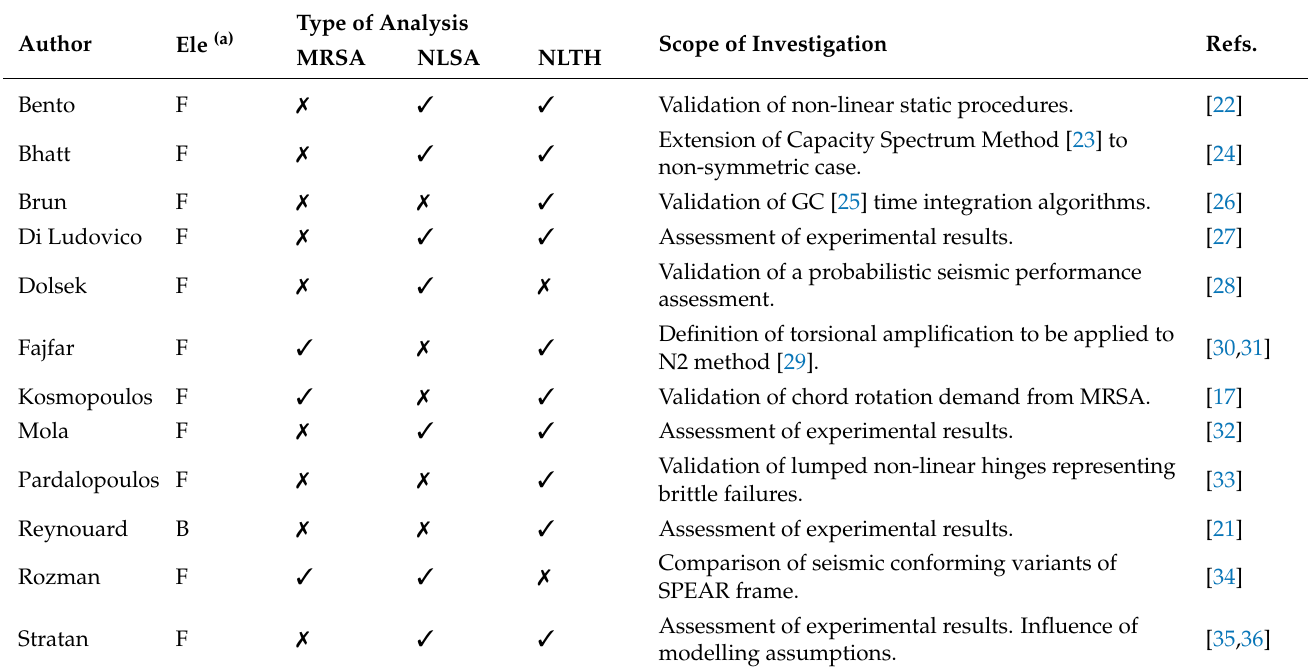
Table 1. Literature survey of numerical studies addressing SPEAR frame.